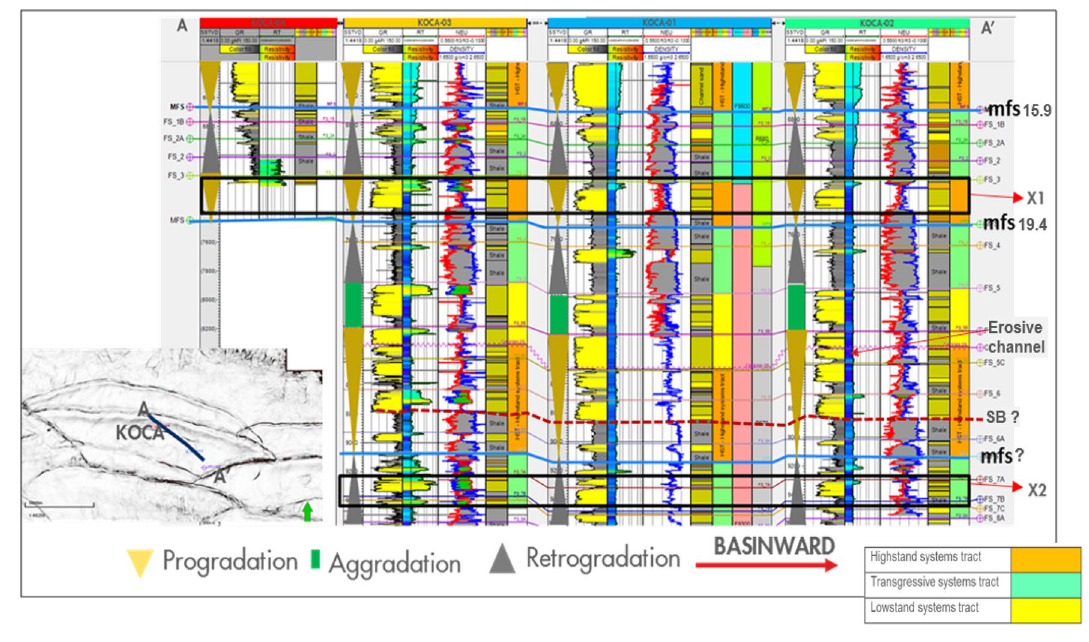
Fig. 9 Sequence stratigraphic framework for the Koca